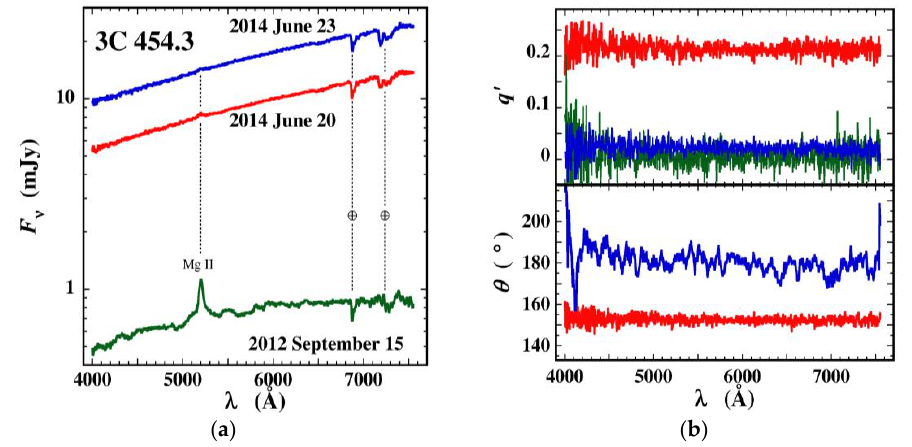
Figure 1. Observations of 3C 454.3 on three separate nights showing the information available to researchers from the spectropolarimetric program. The 2014 data show major changes in both flux ( a ) and linear polarization ( b ) within 3 days during a major γ -ray/optical outburst. Given the extremely low polarization of the object in 2012 (green spectra), the spectrum of θ is not shown in ( b ) for clarity. The Mg II emission line at a redshift of z = 0.859 and telluric spectral features are marked in ( a ). All figures in this article are plotted in the observed